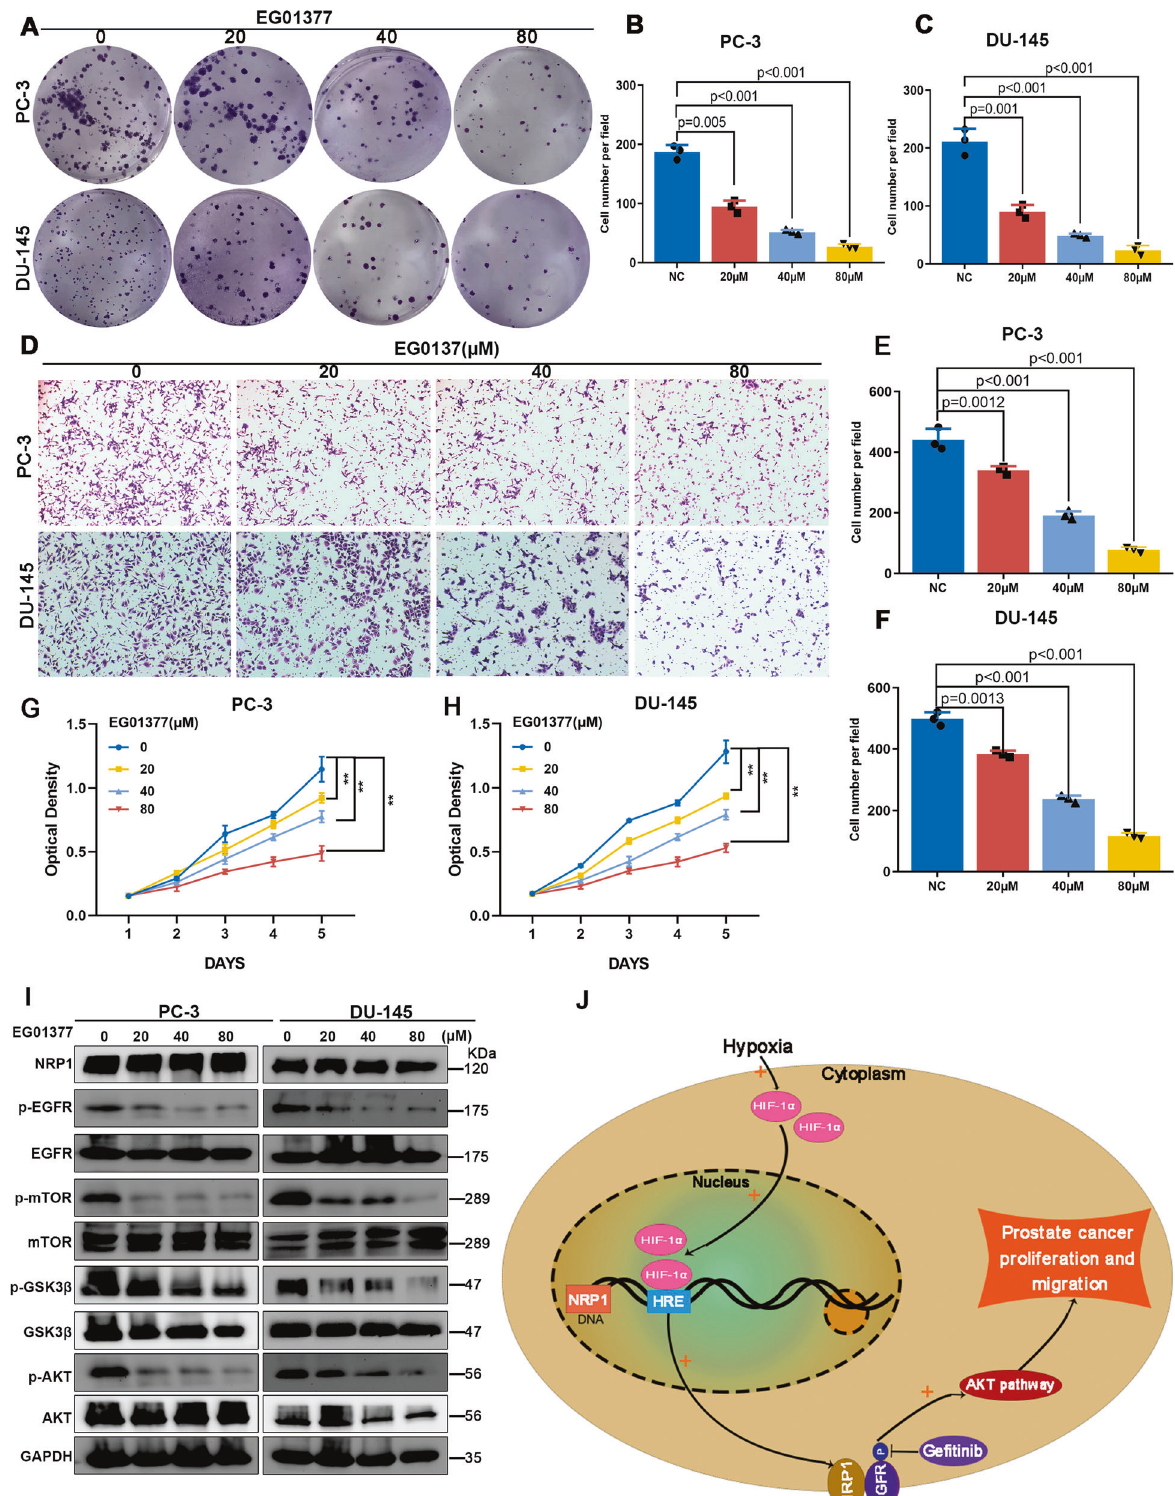
Fig. 8 NRP1 inhibitor EG01377 attenuates PCa proliferation and migration via EGFR/AKT signaling axis. A – C Clone formation assay, D – F transwell assay, and G , H MTT assay represent that NRP1 inhibitor EG01377 attenuates clone formation, proliferation, and migration ability in a concentration-dependent manner. I Immunoblot results elucidate that EG01377 attenuates AKT, GSK3 β , and mTOR phosphorylation levels in a concentration-dependent manner. J A schematic model of HIF1 α -NRP1-EGFR/AKT signaling axis promoting prostate cancer progression. Statistical signi fi cance was assessed using a two-tailed t test. Error bars represent the standard deviations of three independent experiments. ** P < 0.001.